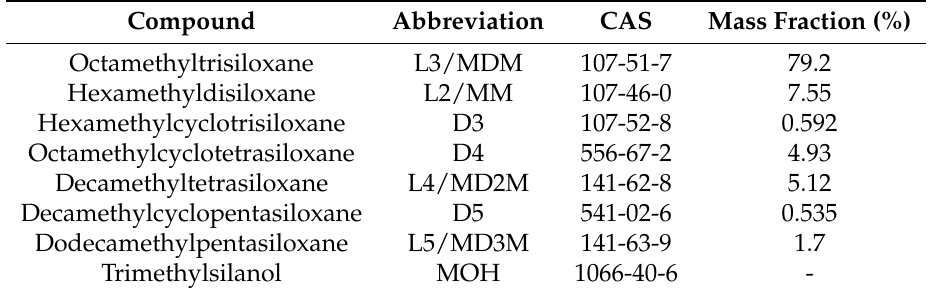
Table 2. HS-GC-MS analysis results of cycle fluid (source: pre-heater after full-stop) [11].